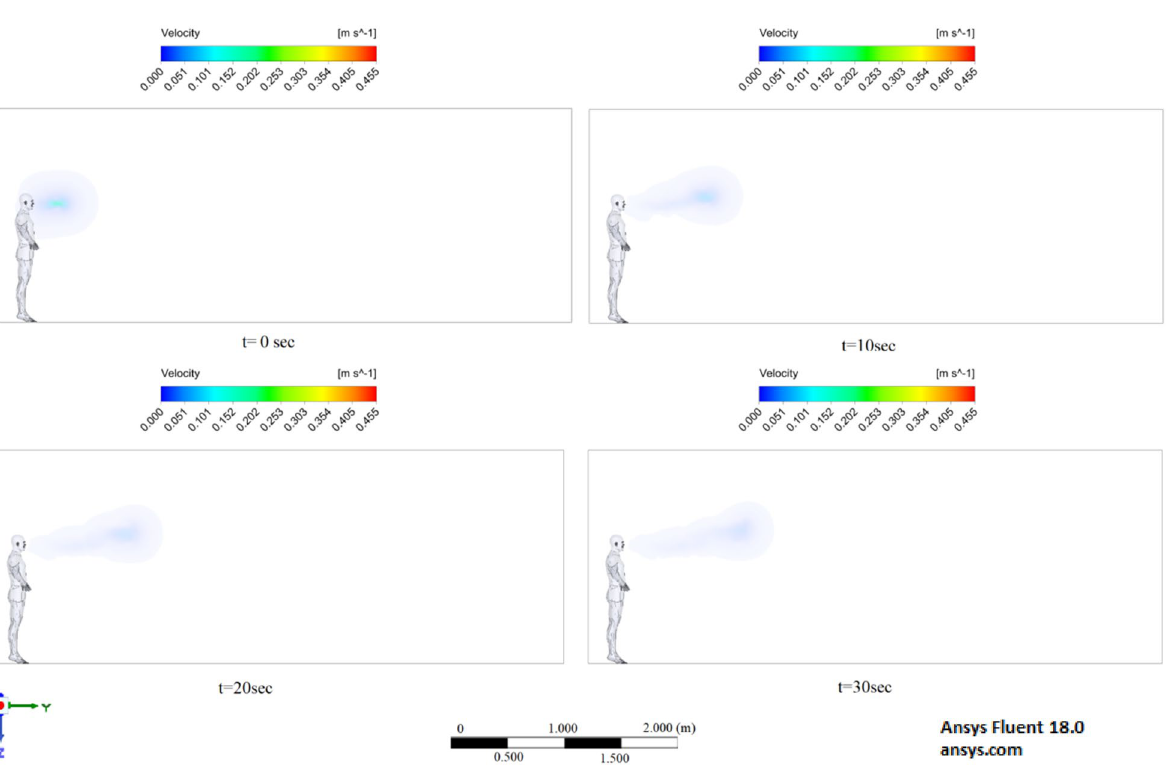
Figure 7. Velocity contours for cough = 6 m/s without